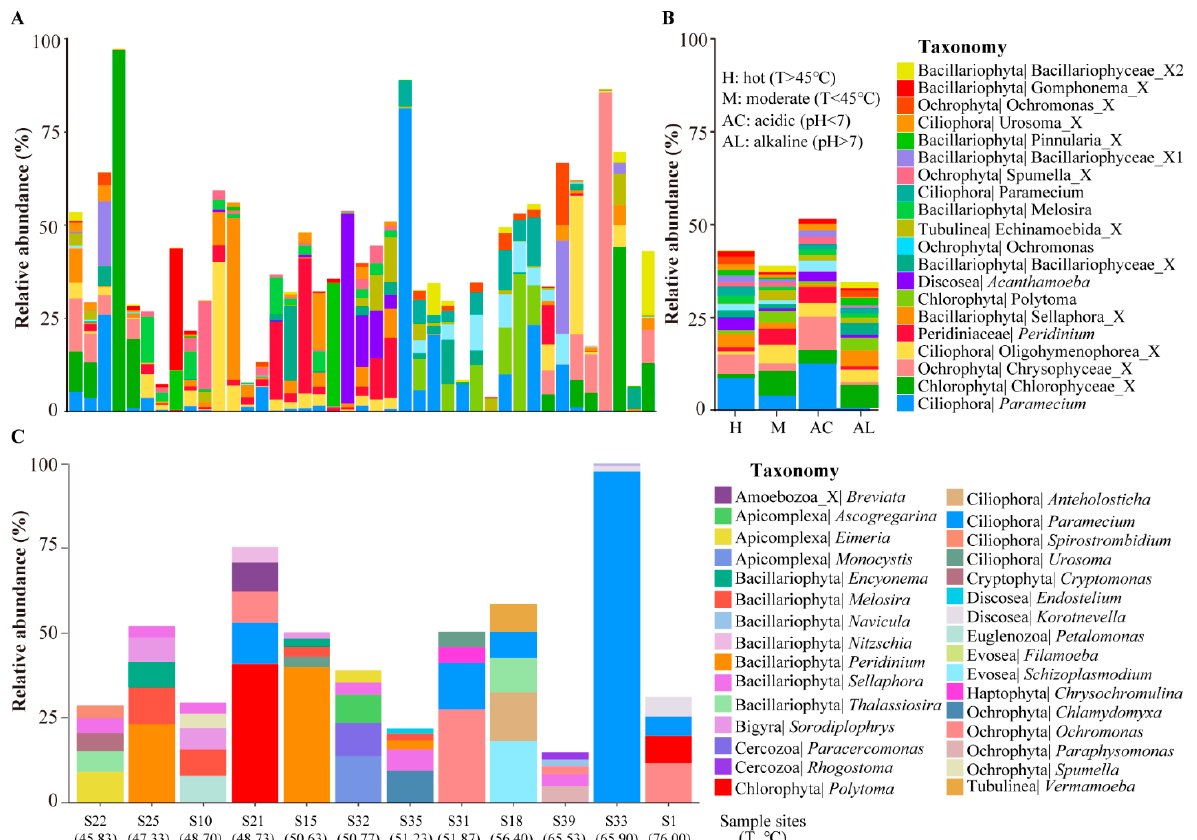
Figure 5. Protists with relatively high abundance in hot springs of HGB. ( A ) The relative abundance of the top 20 ASVs in all sample sites. ( B ) The relative abundance of the top 20 ASVs in hot (H: T > 45 °C), moderate (M: T < 45 °C), acidic (AC: pH < 7) and alkaline (AL: pH > 7) springs. ( C ) The accumulative relative abundance of the top five genus in each of 12 high temperature hot